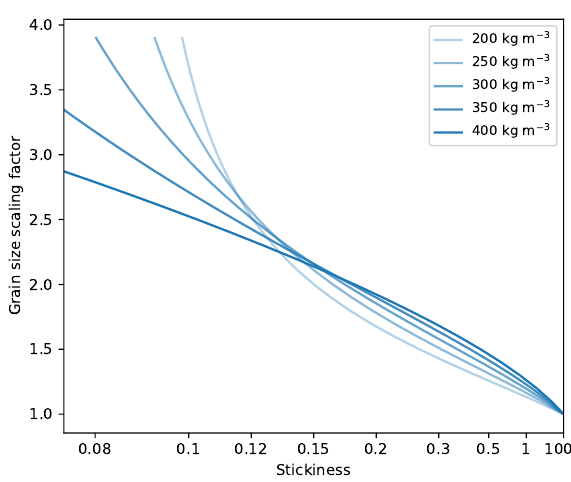
Figure 7. Grain size scaling factor φ SHS needed for simulations with non-sticky hard spheres with a radius φ SHS a to yield the same brightness temperature at V polarization as simulations with sticky hard spheres with a radius a = 100µm. Other parameters are similar to Fig.